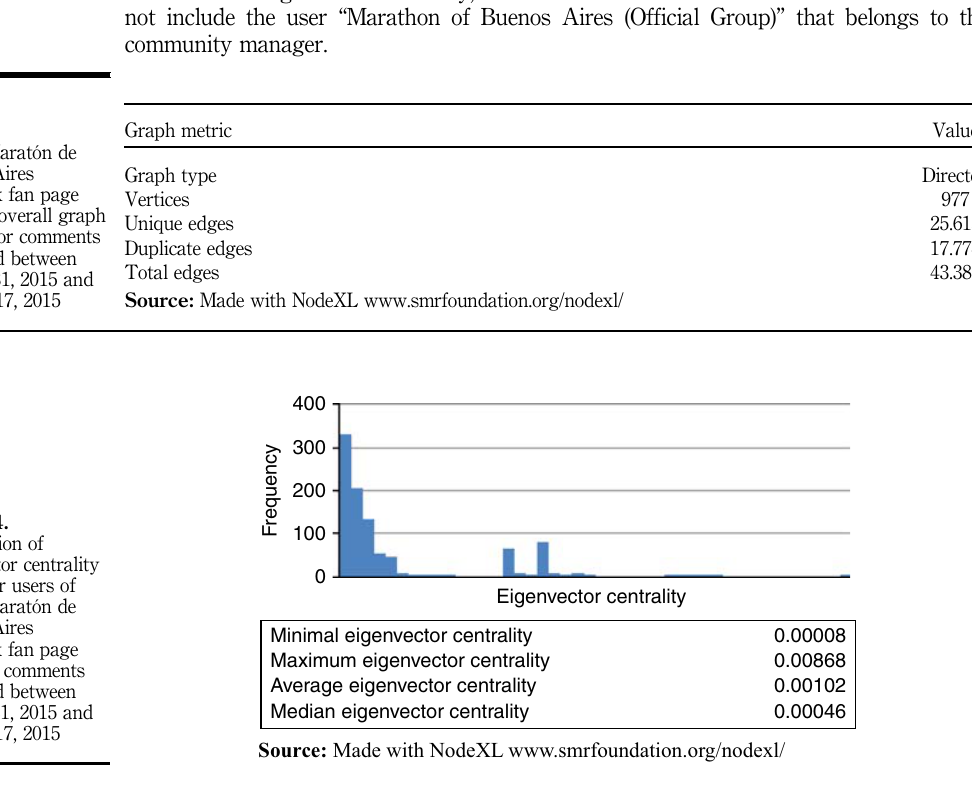
Figure 5. Distribution